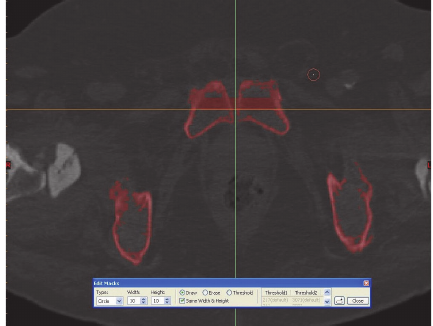
Figure 9: Support bars were drawn across the symphysis pubis and sacroiliac joints to avoid separation on printing the model.